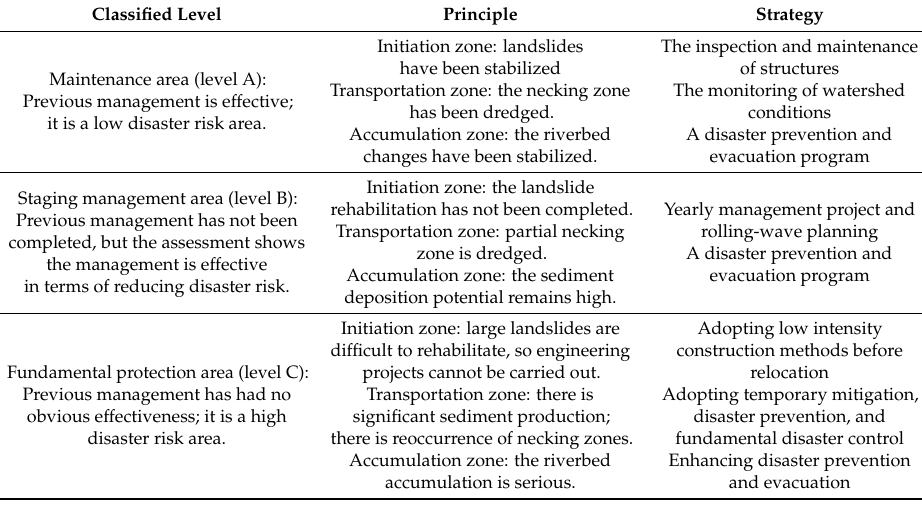
Figure 2. The long-term, detailed landslide inventory and the annual Formosat-2 composites acquired between 2005 and 2016 as released by the Forest Bureau of Taiwan (FBT) to support the open data policy and made available by the Soil and Water Conservation Bureau (SWCB) in the form of vector and image tiles [40]. Table 1. Classified level of mountain and flood control of management